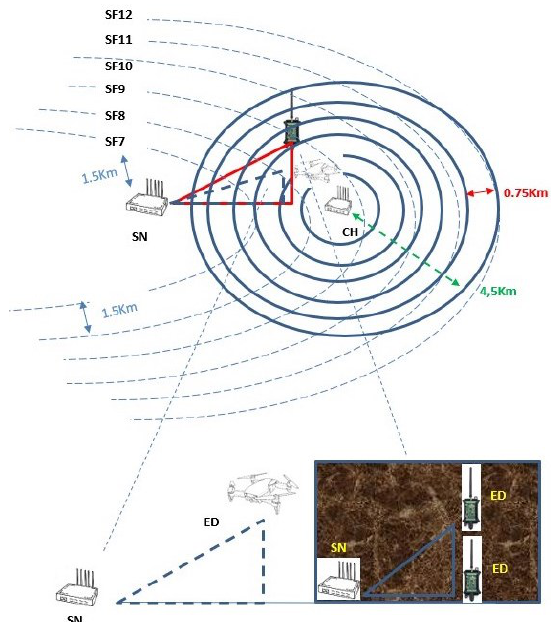
Figure 1. Network